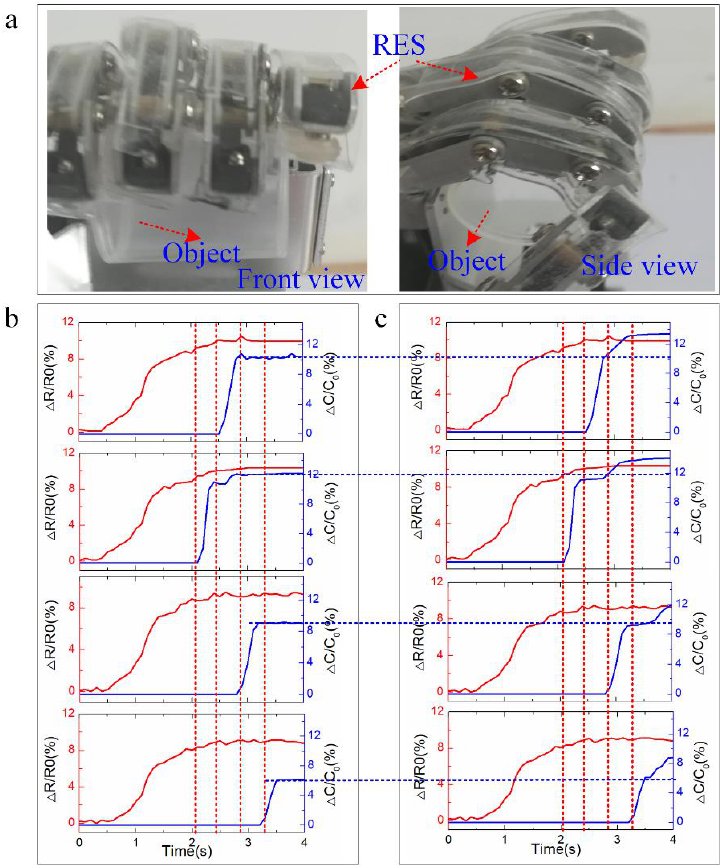
Figure 7. Strain data distribution during the grasping process of the robotic finger with force negative feedback. ( a ) Optical image of robot finger with RES for grasping plastic lid; Strain and pressure distribution during the grasping of the plastic lid process ( b ) with force negative feedback and ( c ) without force negative feedback.